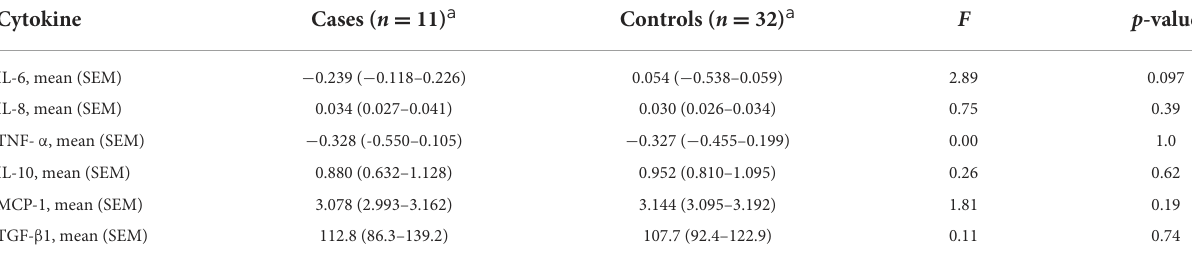
TABLE 3 Differences in cytokine levels between cases and controls after correction of confounding factors (age and body mass index). Cytokine Cases ( n = 11)